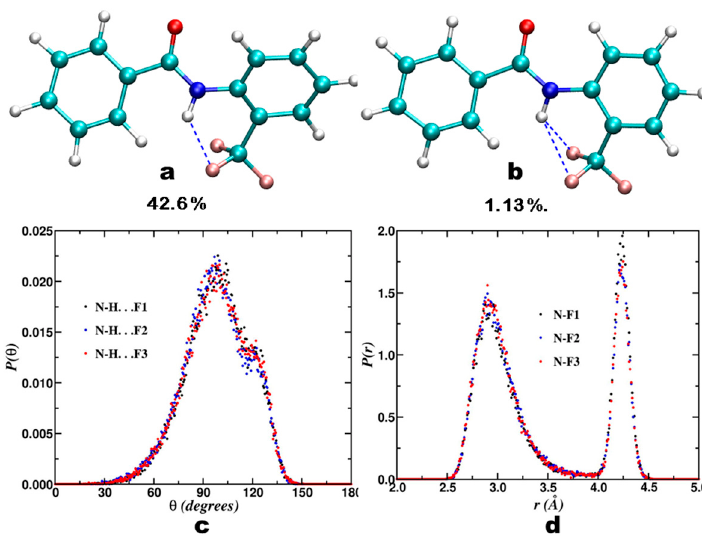
Figure 10. ( a , b ) Snapshot of HB formation in molecule 6 , along with their percentage of occurrence, obtained from MD simulations. Blue colored dashed lines show H-bonds; ( c , d ) Probability distributions of angles and distances, respectively.